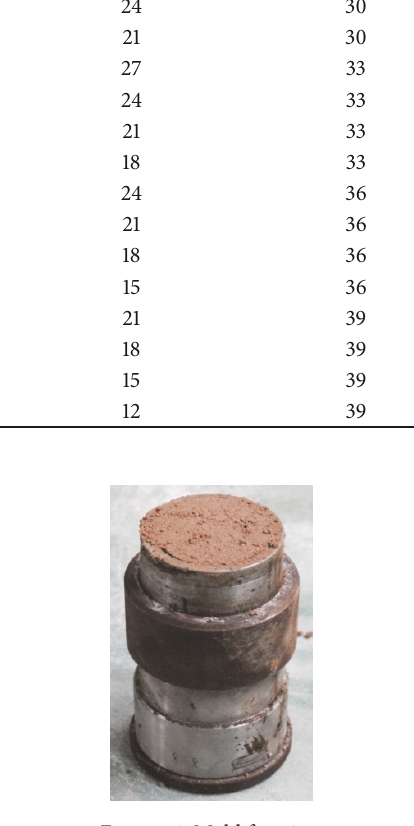
Figure 4: Mold forming.